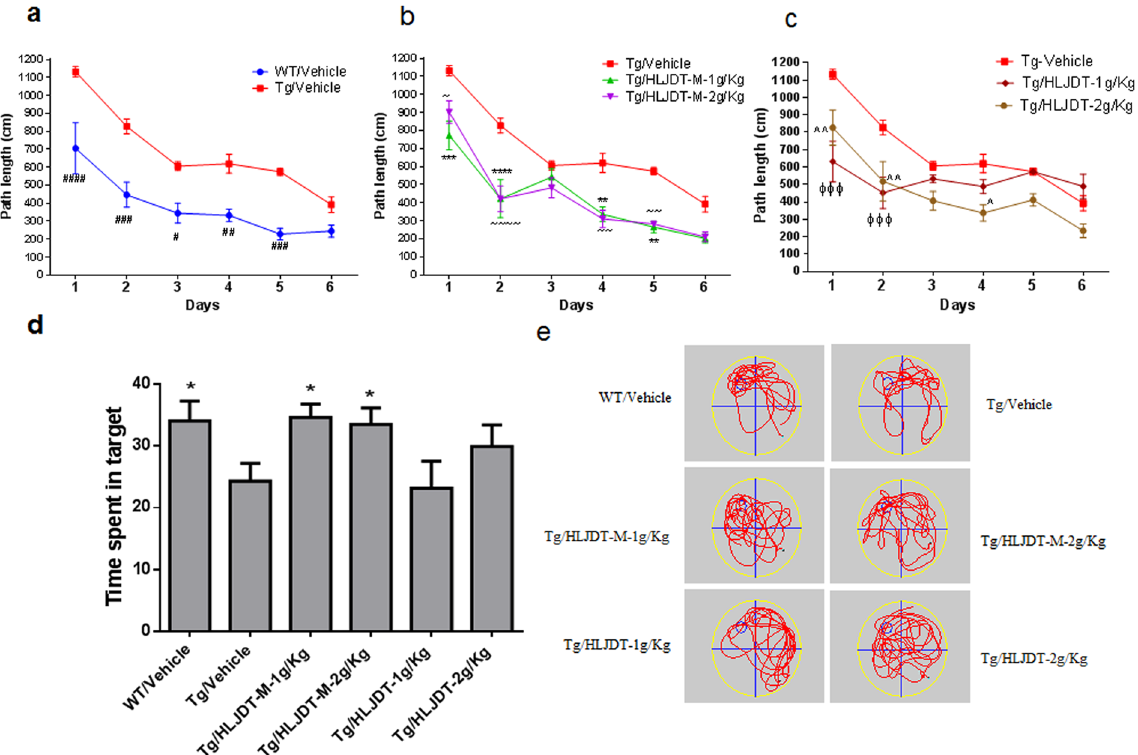
Figure 2. Behaviour study of HLJDT and HLJDT-M on 3XTg-AD mice. Acquisition of spatial memory was evaluated by Morris water maze (hidden platform) in HLJDT, HLJDT-M and vehicle-treated 3XTg-AD mice ( a , b , c ). Results are represented as the mean length values ± standard error of the mean (SEM) of all mice from 4 trials per day (n = 10). In probe trial, mice are evaluated for the amount of time spent in searching the platform location after 24-hour retention trial in MWM ( d , e ). In the probe trial, the HLJDT-M treated mice stayed longer in the target quadrant than the vehicle-treated mice, showing memory retention. The symbol denotes statistical differences among the given groups over all trial days. ### p < 0.001 (WT treated with vehicle vs. Tg treated with vehicle); *** p < 0.001 (Tg treated with HLJDT-M at 1 g/kg vs. Tg treated with vehicle), ~~~p < 0.001 (Tg treated with 2 g/kg of HLJDT-M vs. Tg treated with vehicle), ^^p < 0.01 (Tg treated with 1 g/kg of HLJDT vs. Tg treated with vehicle) and ΦΦΦ p < 0.001 (Tg treated with 2 g/kg of HLJDT vs. Tg treated with